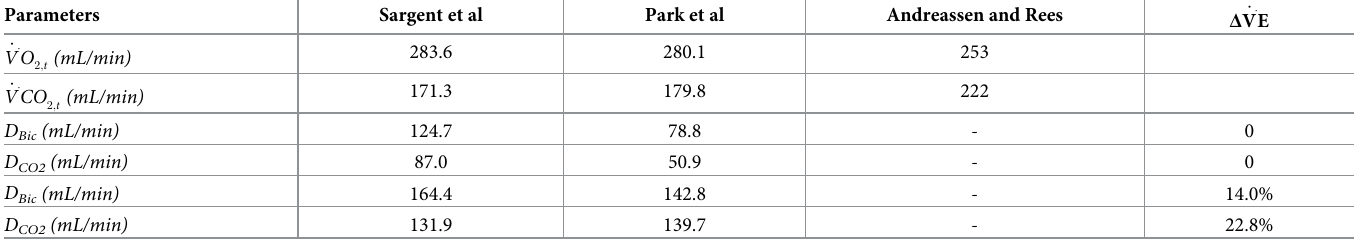
and _ V _ CO ). The dialysances D Bic and D CO2 are shown first for 2 ; t 2 ; t ) was assumed. E